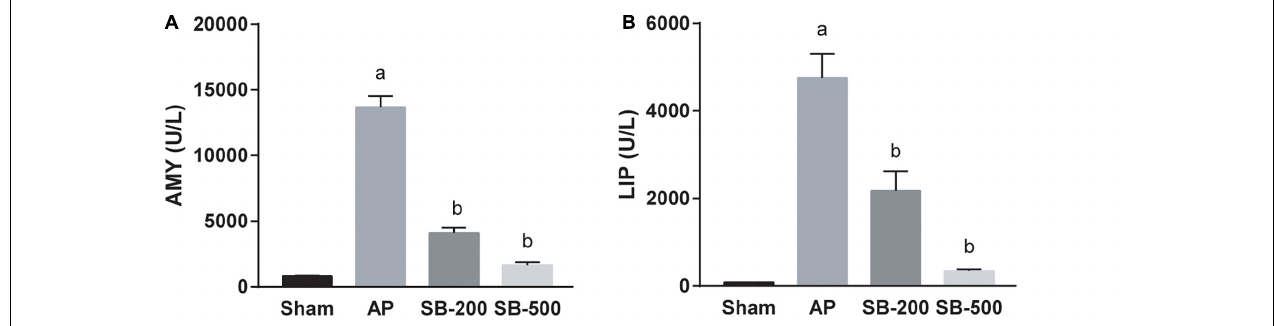
FIGURE 1 | Concentrations of AMY and LIP in the serum of mice in each group. The (A) AMY and (B) LIP concentration in the serum of mice in each group. n = 8. The data was presented as the mean ± standard error of the mean. a p < 0.05 vs. Sham group. b p < 0.05 vs. AP group. AMY, amylase; LIP, lipase; Sham, Sham operation group; AP, acute pancreatitis group; SB-200, 200 mg/kg butyric acid intervention group; SB-500, 500 mg/kg butyric acid intervention group.